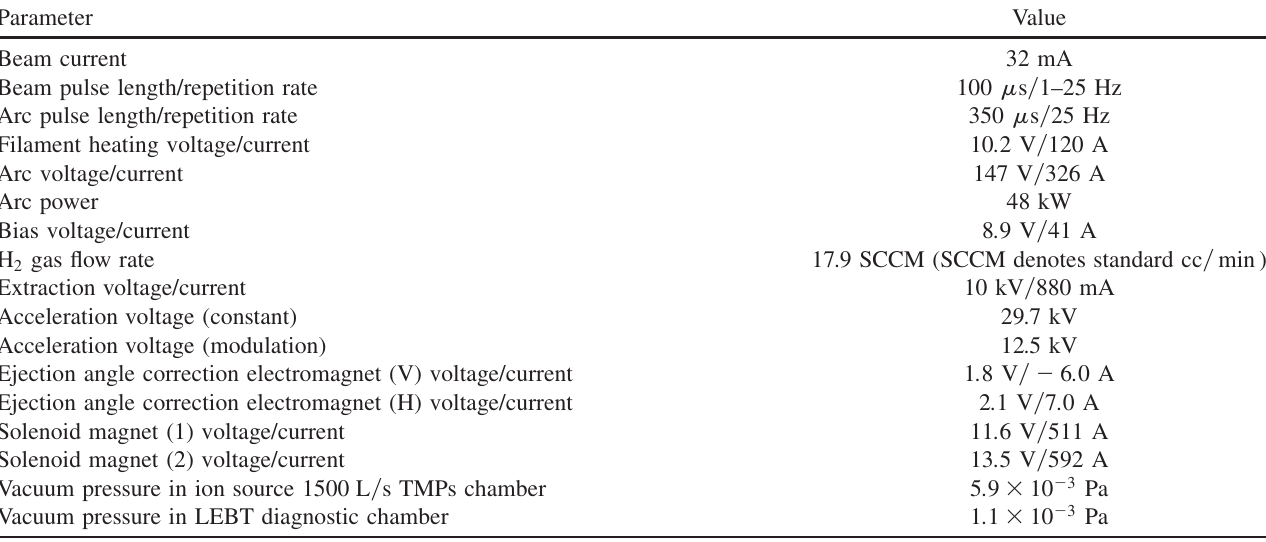
TABLE I. Typical operation parameters of ion source and LEBT during beam commissioning in high current mode.